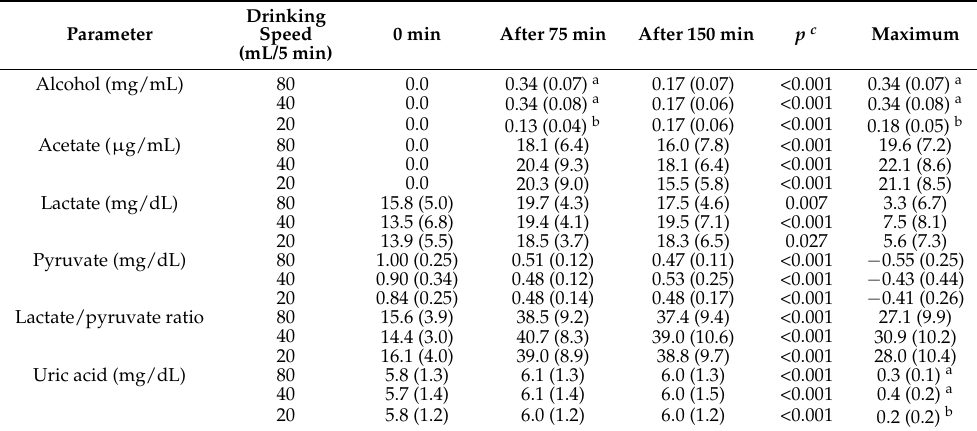
Table 3. Temporal changes and maximum amount of change from 0 min of each blood or serum parameter concentration in the crossover